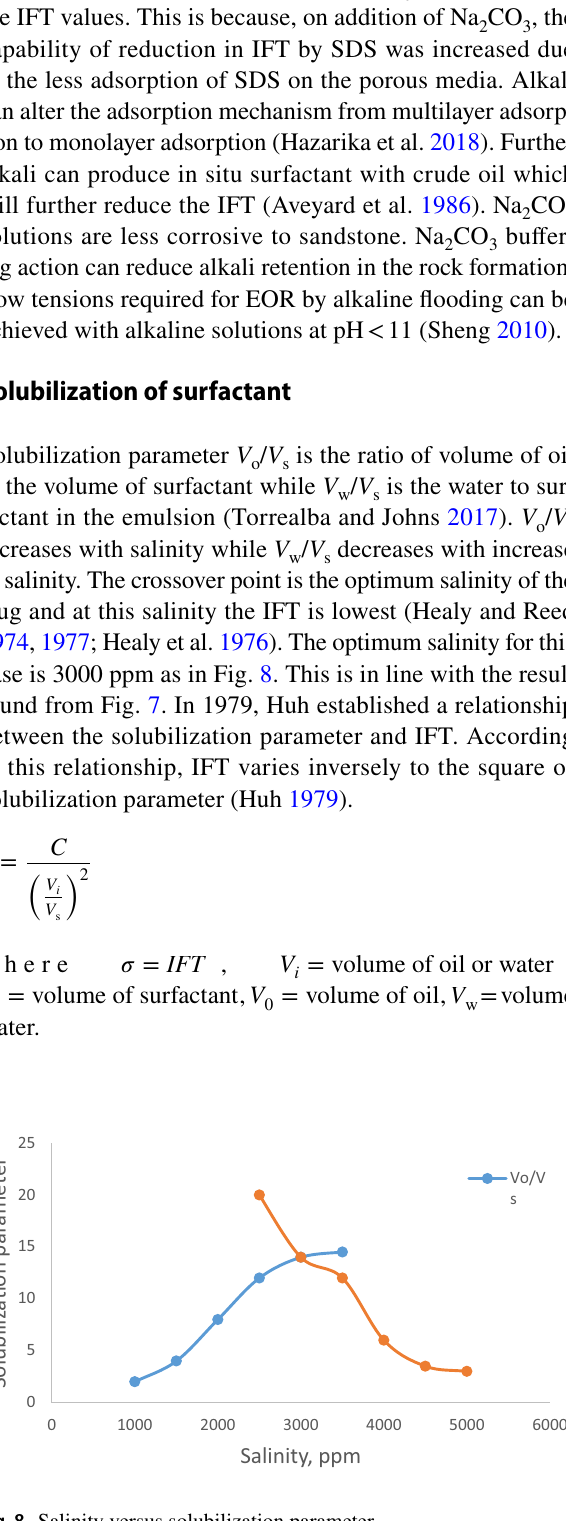
Fig. 8 Salinity versus solubilization parameter